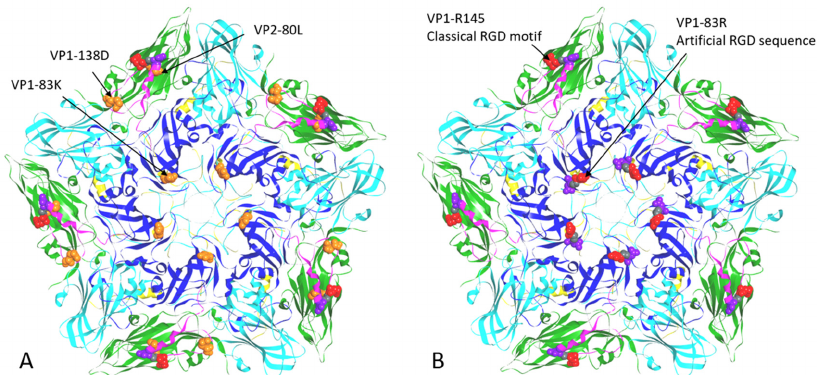
Figure 2. Locations of site-directed mutations in one of the twelve pentamers of ( A ) rHN M2080L+G1138D and ( B ) rHN K1083R . The crystallographic coordinates of O1BFS (1FOD) were used for molecular modeling [40]. The ribbon diagram of a pentamer composed of five copies of protomers is shown with the respective color codes of VP1 (blue), VP2 (green), VP3 (cyan) and VP4 (yellow, internal). The conformation of the VP1 G–H loop (130–165 residues) is highlighted in magenta. The specific amino acid residues at positions 80 (Leu, orange) in VP2, as well as 83 (Lys, orange) and 138 (Asp, orange) in VP1 of rHN M2080L+G1138D , the artificial RGD sequence (83–85 residues, red-grey-purple) and the classical RGD motif (145–147 residues, red-grey-purple) in VP1 of rHN K1083R , are labeled as space-filling models.